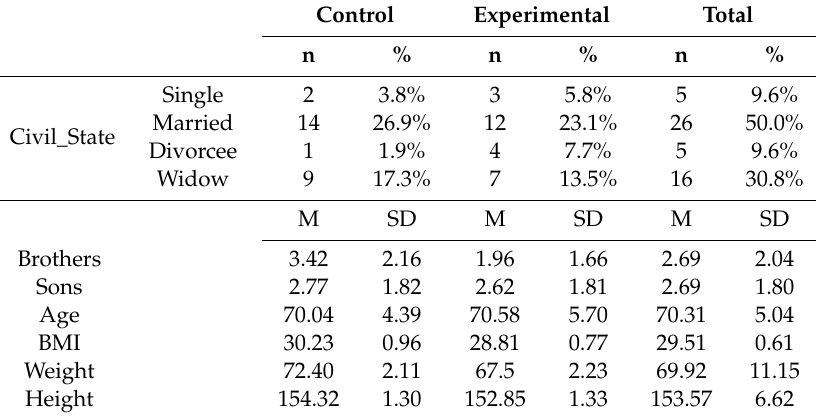
Table 1. Sociodemographic characteristics of the